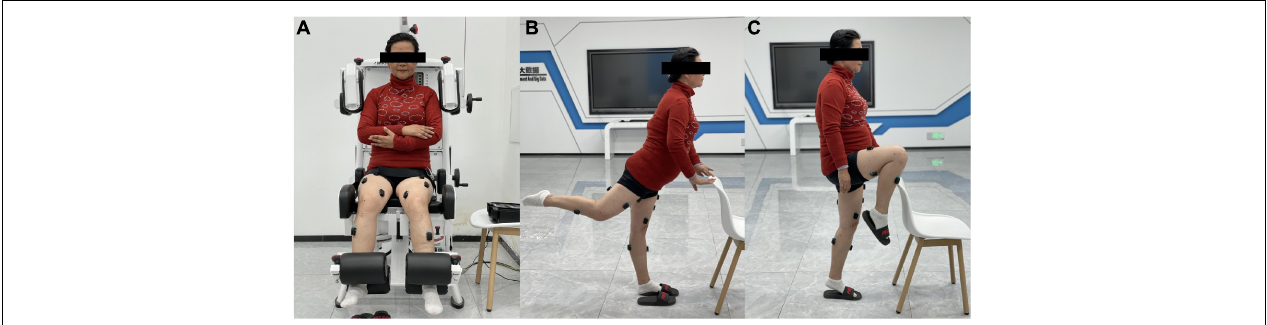
FIGURE 1 | Surface electromyography (sEMG) amplitude normalization tests: (A) for vastus lateralis/vastus medialis/rectus femoris/biceps femoris/tibialis anterior (VL/VM/RF/BF/TA), (B) for gluteus maximus (GMAX), and (C) for medial head of gastrocnemius (MG).